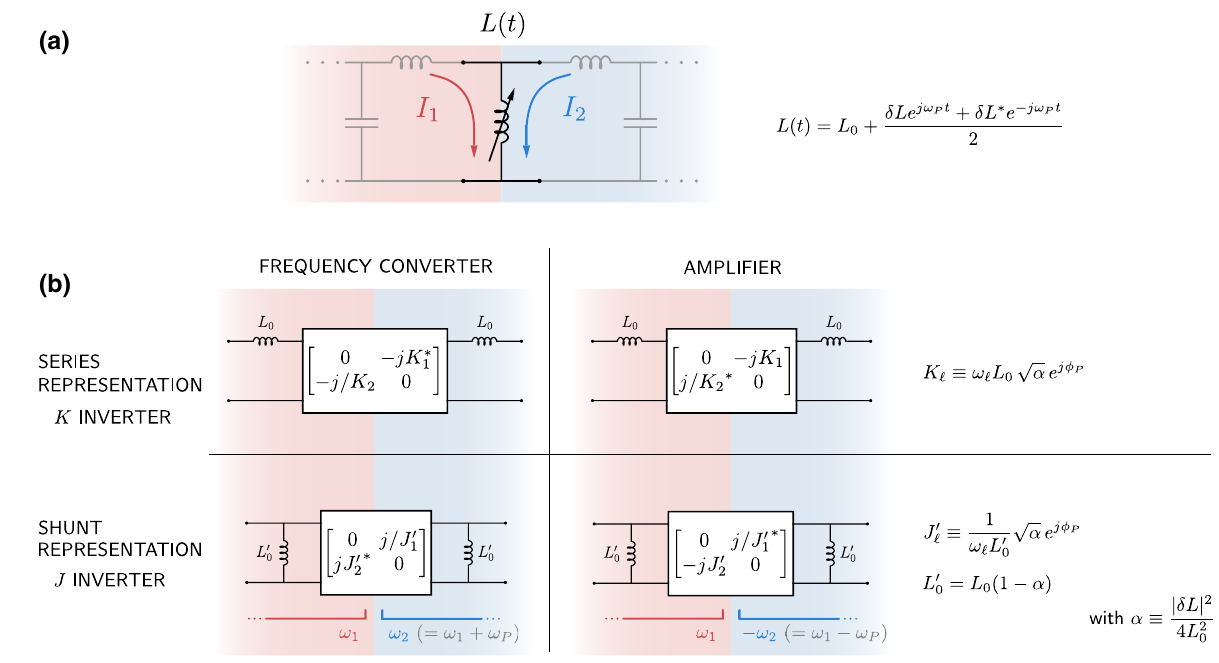
FIG. 8. (a) Modulated inductor model with signal and idler branch currents I 1 and I 2 . An example embedding circuit is shown (grayed out) to provide context. (b) Equivalent two-port circuit models for the series and shunt representations of the modulated induc- tor. The boxed elements represent impedance or admittance inverters, with the corresponding ABCD matrices shown. The constants are defined in the K (cid:11) , J (cid:12) (cid:11) , and L (cid:12) 0